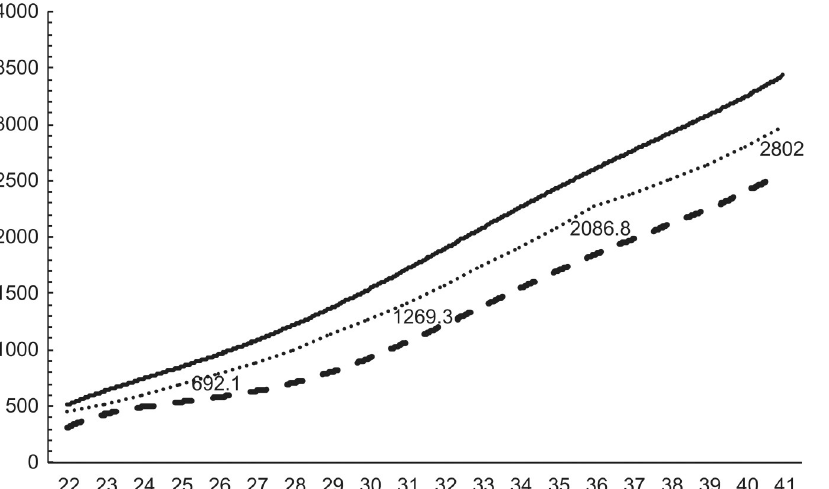
Fig 5. Birth weight reference curves for each week (female,